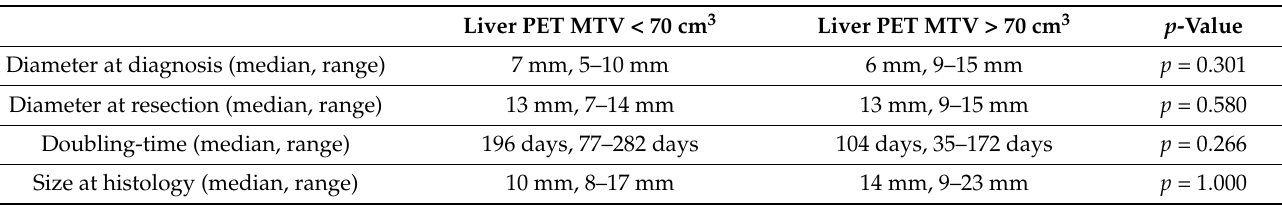
Table 2. Largest diameter on CT scans at time of diagnosis and time of resection of pulmonary metastases, doubling- time of pulmonary metastases and largest diameter at